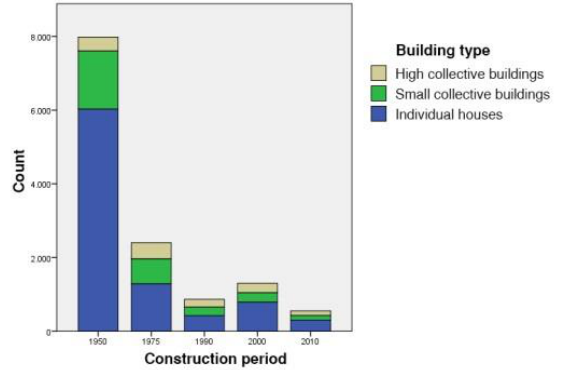
Figure 2: Description of the repartition of building types per building age of the total sample.